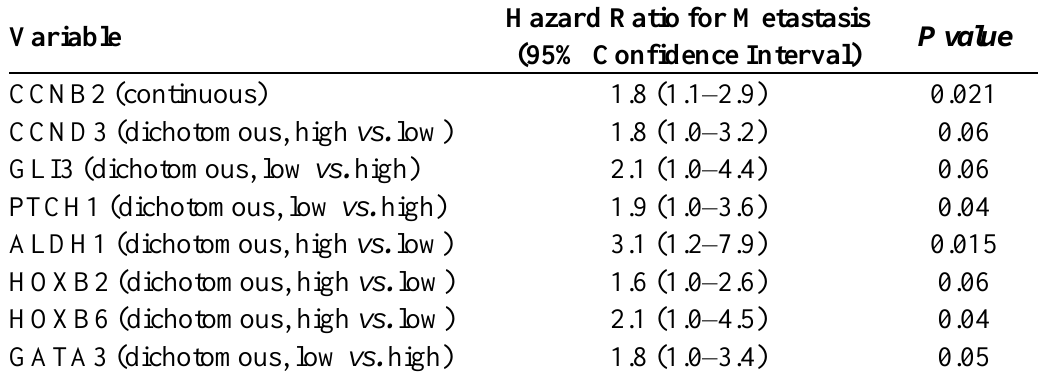
Table 1. Risk of metastasis among postmenopausal patients with ER-positive breast cancer treated with radical or conservative surgery plus radiotherapy and adjuvant tamoxifen.